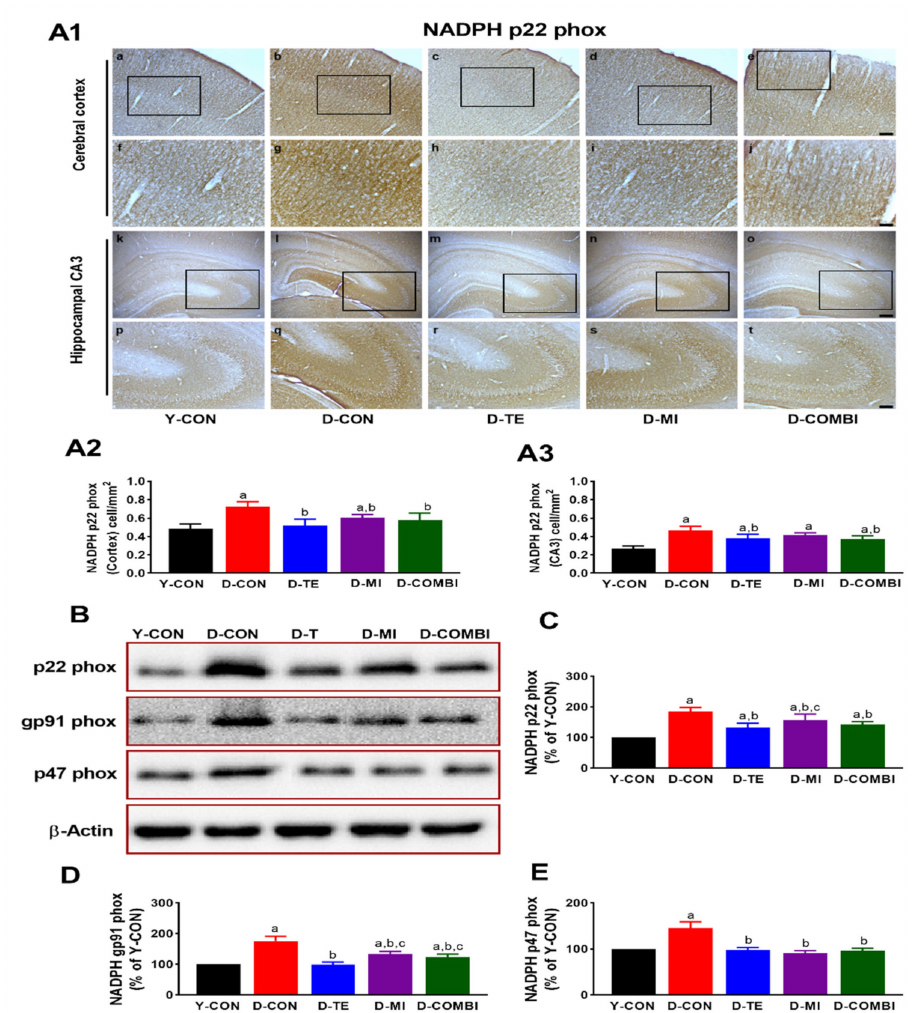
Figure 2. Effects of treadmill exercise and MitoQ on the expression of NADPH oxidase subunits in the cerebral cortex and hippocampus of D-gal induced aging rats. ( A1 ) Photomicrographs showing NAPDH p22 phox immunoreactivity in the cerebral cortex and hippocampus of D-gal induced aging rats in each group. Black rectangles in A1 indicate the portion of the images as shown in f – i and p – t . ( A2 , A3 ) Optical density quantification of NADPH p22 phox staining in the cerebral cortex and hippocampus. Bonferroni post hoc test after ANOVA. Values are presented as means ± SEM. ( n = 5 animals). ( a – e and k – o ) Scale bar = 100 µ m, ( f – j and p – t ) Scale bar = 50 µ m. ( B ) Representative Western blot images for NADPH oxidase subunits in the hippocampus. ( C – E ) Quantitation of NADPH oxidase subunits in the hippocampus. The data shown in the Western blot were means from seven rat brains. β -Actin was probed as an internal control. Bonferroni post hoc test was used after ANOVA. Values are means ± SEM. a Denotes statistical difference from the Y-CON group. b Denotes statistical difference from the D-CON group. c Denotes statistical difference from the D-TE group. ( p <